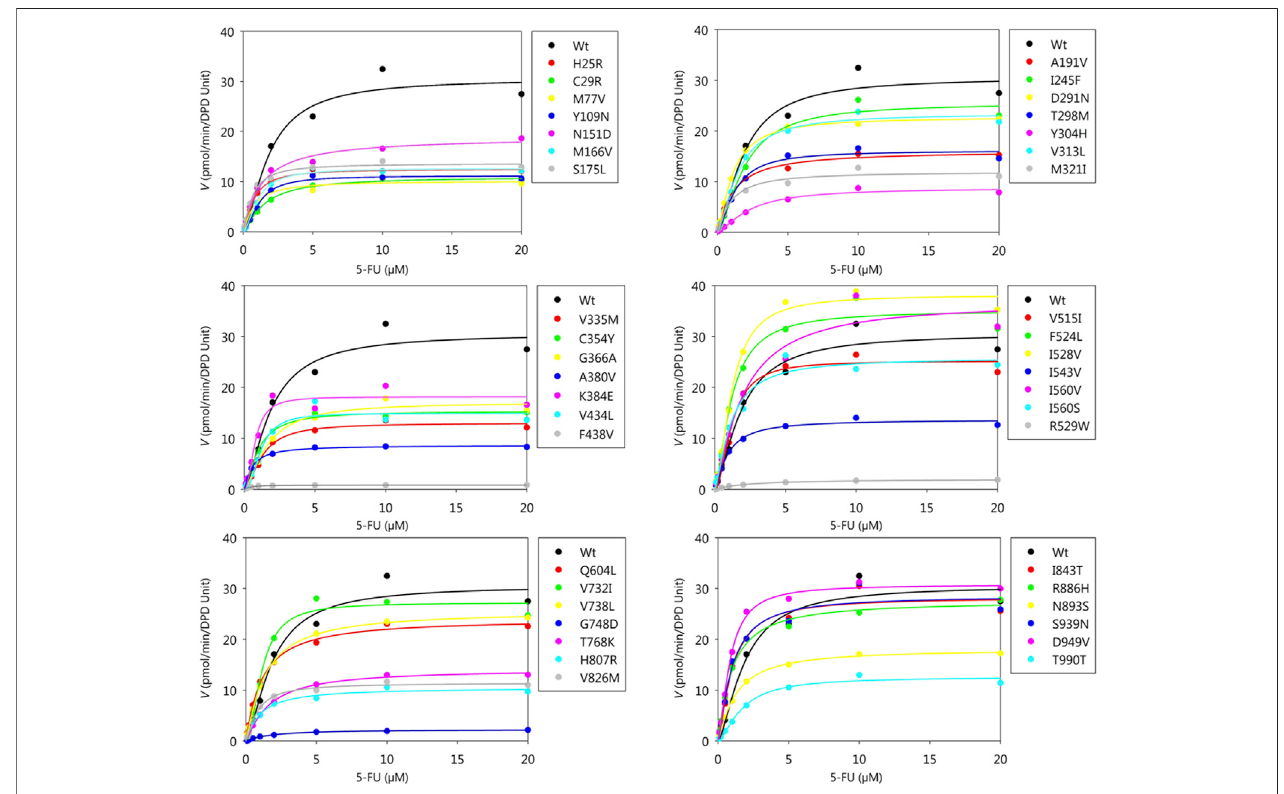
FIGURE 3 | Michaelis-Menten curves of DPD variants. The kinetic parameters K m , V max , and CL int of 5-FU reduction were determined. The velocities for the reduction of 5-FU and 5-FU concentration are plotted on the horizontal and vertical axes, respectively.